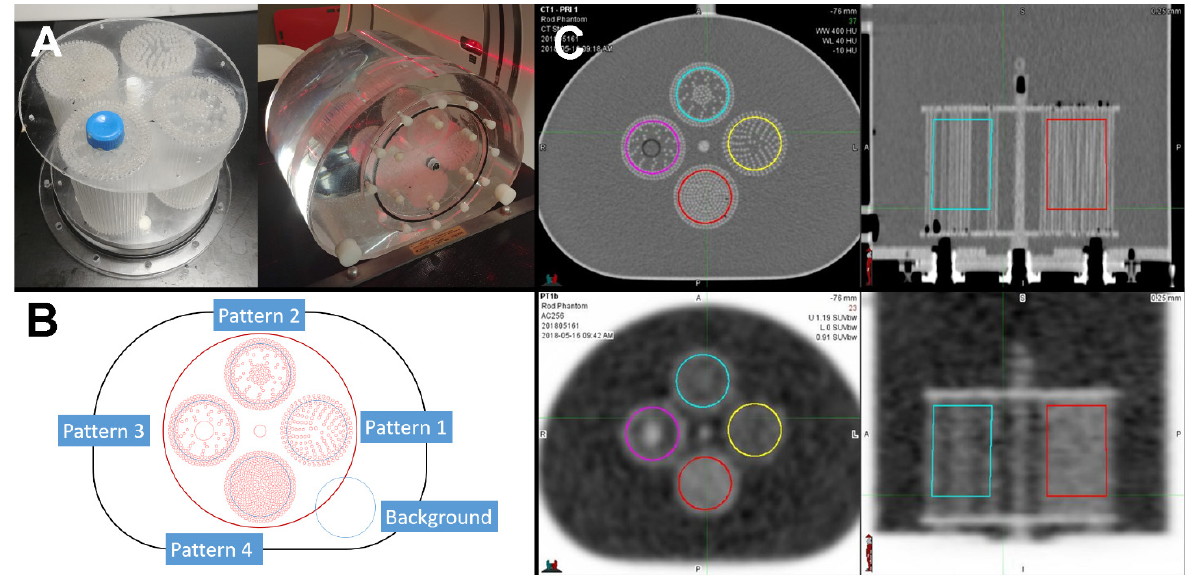
Figure 1. Texture phantom used for this study. ( A ) Photographs of the manufactured cylindrical texture compartments inserted into a standard NEMA phantom shell. ( B ) Each compartment mimics a different distribution of radiotracer uptake due to a different structural pattern of blocked space. ( C ) Axial and coronal CT and PET images of the phantom.